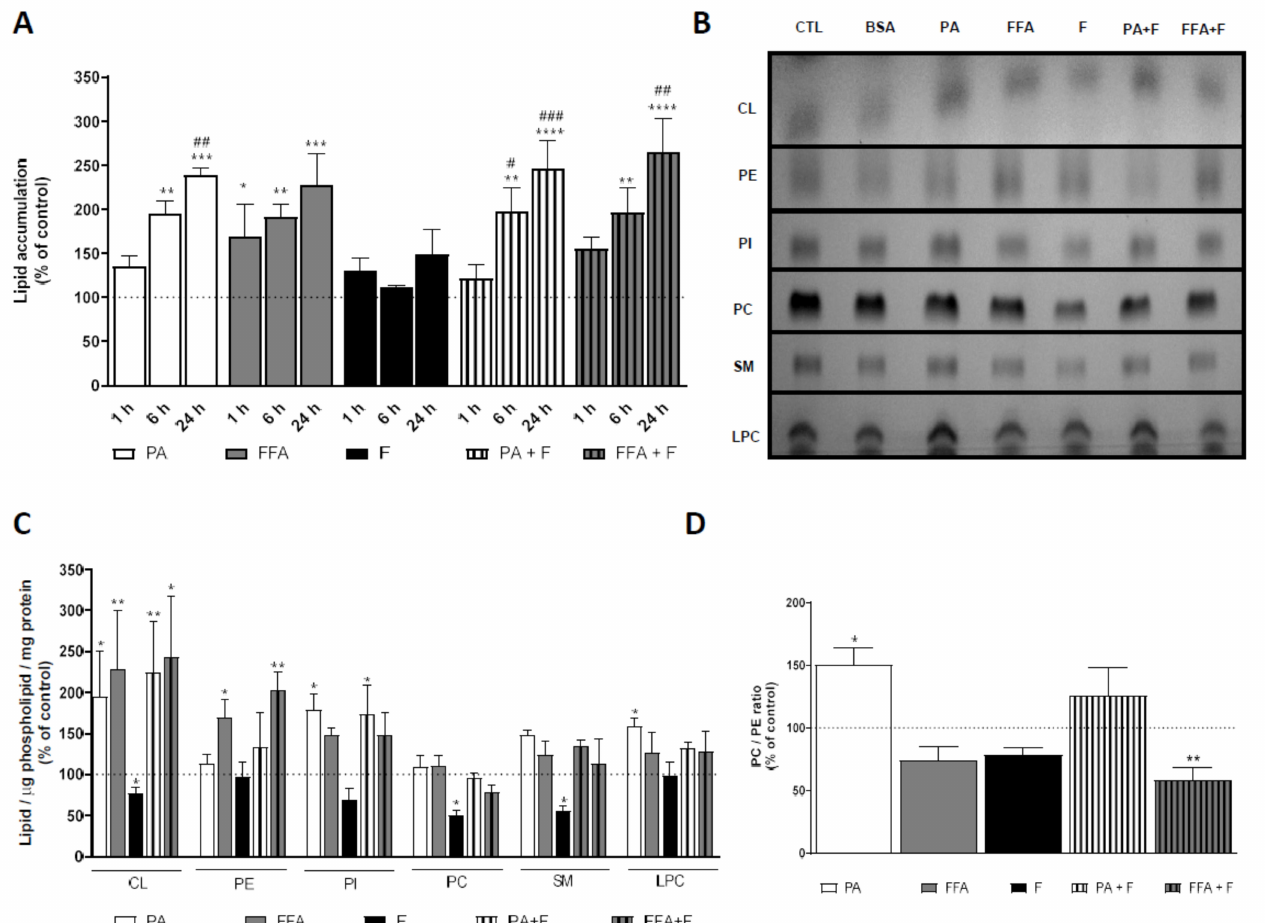
Figure 1. Effect of supra-physiological concentrations of FA on the accumulation of lipid and mitochondrial phospholipids content. ( A ) Lipid droplet content in HepG2 cells treated with palmitic acid (PA, 0.5 mM) or a mix of free fatty acids (FFA, 0.25 mM) in the presence or absence of fructose (F, 10 mM) for 1, 6, and 24 h. ( B ) A typical chromatogram showing the mitochondrial phospholipids profile (CL, cardiolipin; PE, phosphatidylethanolamine; PI, phosphatidylinositol; PC, phosphatidylcholine; SM, sphingomyelin; LPC, lysophosphatidylcholine) of HepG2 cells treated with PA or FFA in the presence or absence of F for 24 h. This image was inverted and contrast-optimized for visualization purposes. Quantification of the bands was performed using the original images. ( C ) Quantification of phospholipid content (CL, PE, PI, PC, SM, and LPC) in multiple experiments. ( D ) PC/PE ratios obtained in all conditions. Data are the mean ± SEM of four independent experiments, and the results normalized on the control condition (CTL = 100%, marked by a dotted line). Significance was accepted with * p < 0.05, ** p < 0.01, *** p < 0.0005, **** p < 0.0001 for comparations between treatment vs. CTL (BSA 0.01 g/mL) and # p < 0.05, ## p < 0.01, ### p < 0.0005 for comparations during time in the same group (24 and 6 h vs. 1